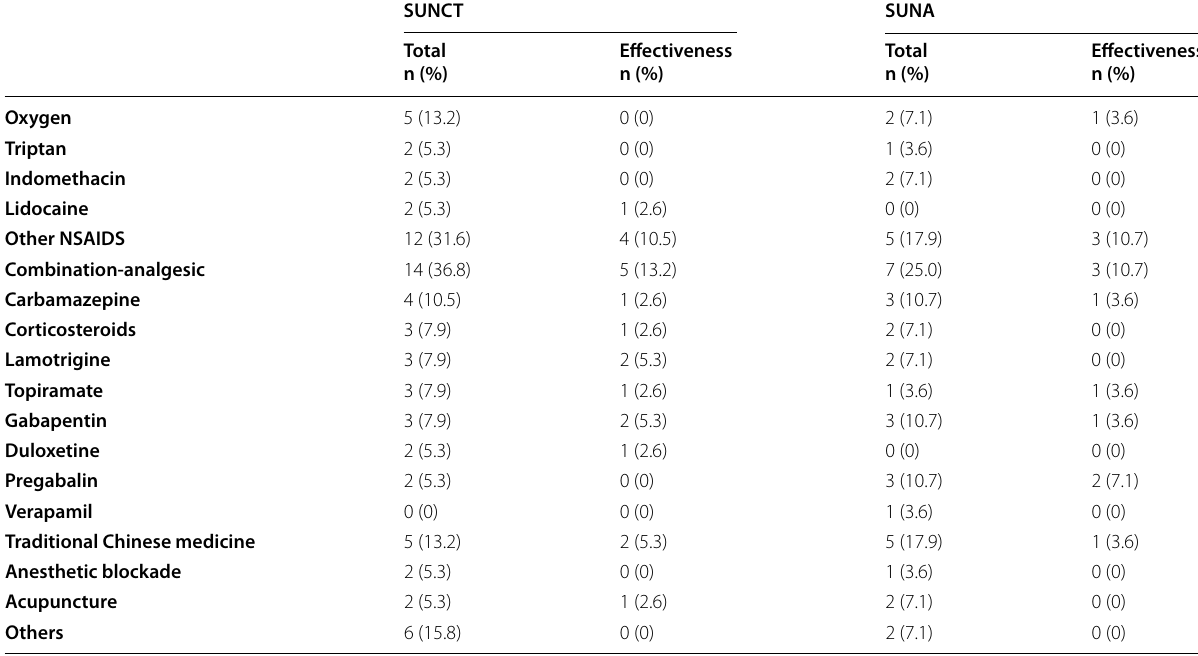
Table 4 Treatment in patients with SUNCT ( n